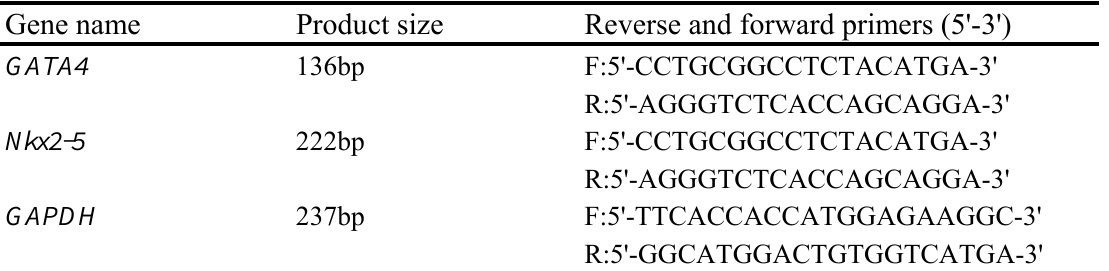
Table 1. Sequences of the primers used in this